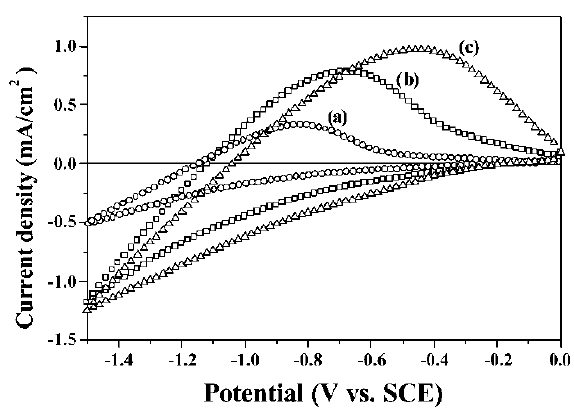
FIGURE 3 Cyclic voltammograms of colloidal TiO 2 thin films, at various scan rates: (a) 5mV = s, (b) 20mV = s and (c) 50mV